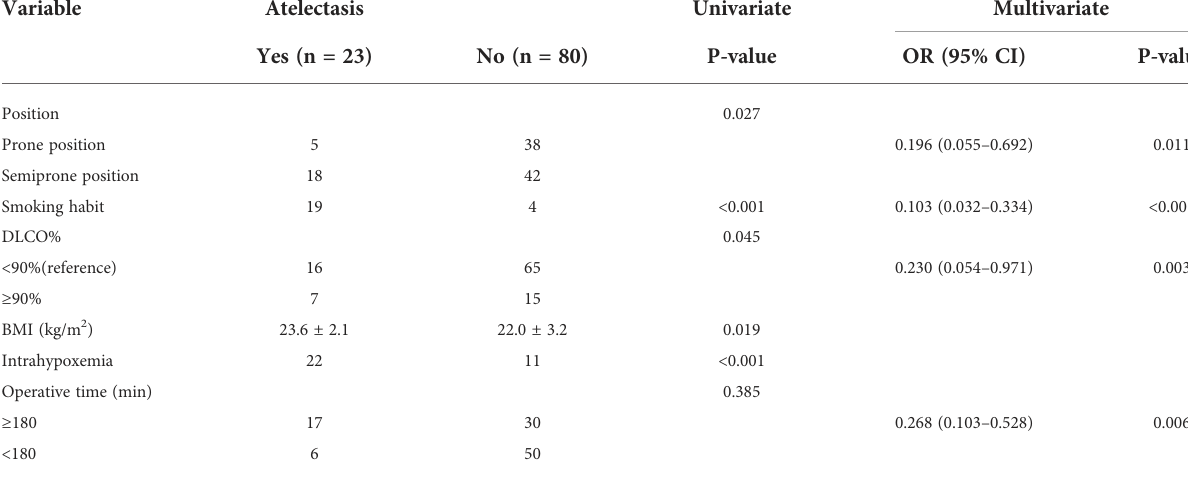
TABLE 5 The results of the bivariate and multivariate analyses of the factors associated with atelectasis.